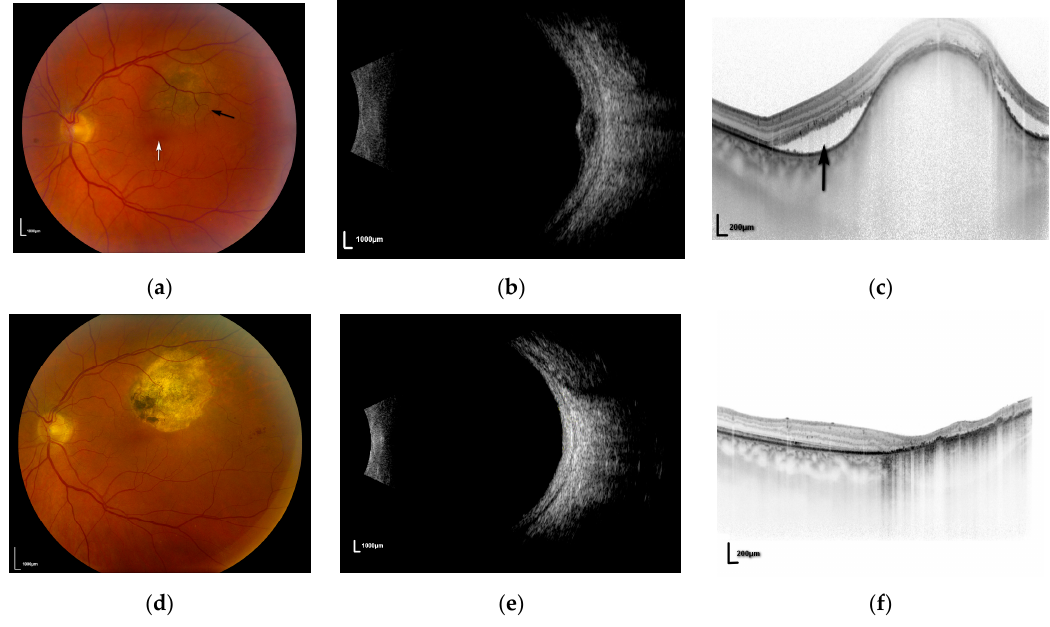
Figure 1. ( a ) Fundal photograph of left eye showing melanoma ( black arrow ) adjacent to the fovea ( white arrow ); ( b ) ultrasound of lesion in Figure 1a; ( c ) ocular coherence tomography (OCT) scan demonstrating sub-retinal fluid ( black arrow ); ( d ) post-treatment fundal photograph showing flat scar; ( e ) post-treatment ultrasound demonstrating flat scar; ( f ) post-treatment OCT showing resolution of sub-retinal fluid.